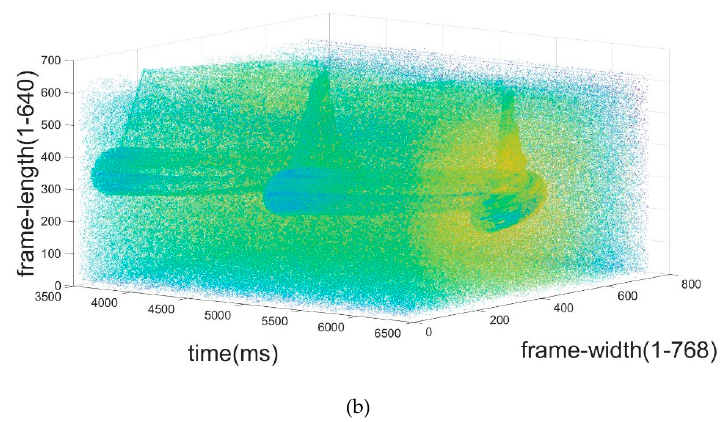
Figure 5. Filtering result of the method in this paper: ( a ) is the result of denoising and ( b ) is the filtered noise.